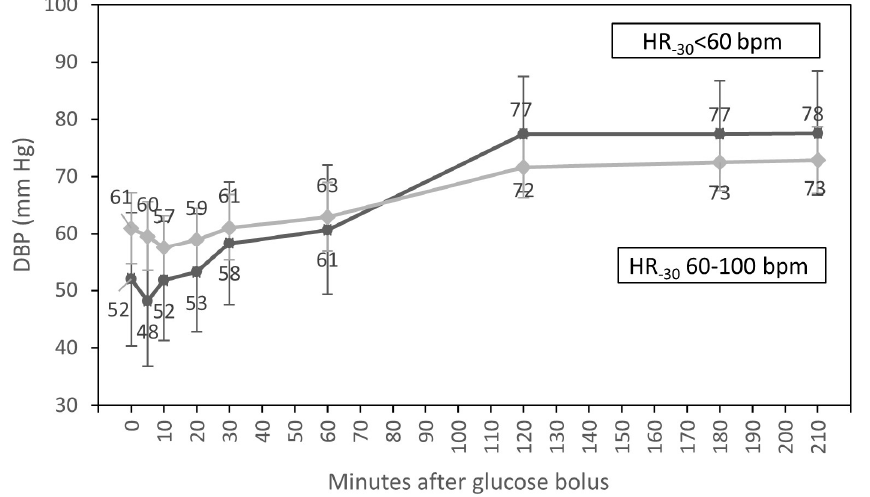
Figure 3. Course of diastolic blood pressure (estimated marginal means, 95% CI) for groups with HR <60 bpm and HR from 60 to 100 bpm at the beginning of hemodialysis, adjusted for diabetic status and